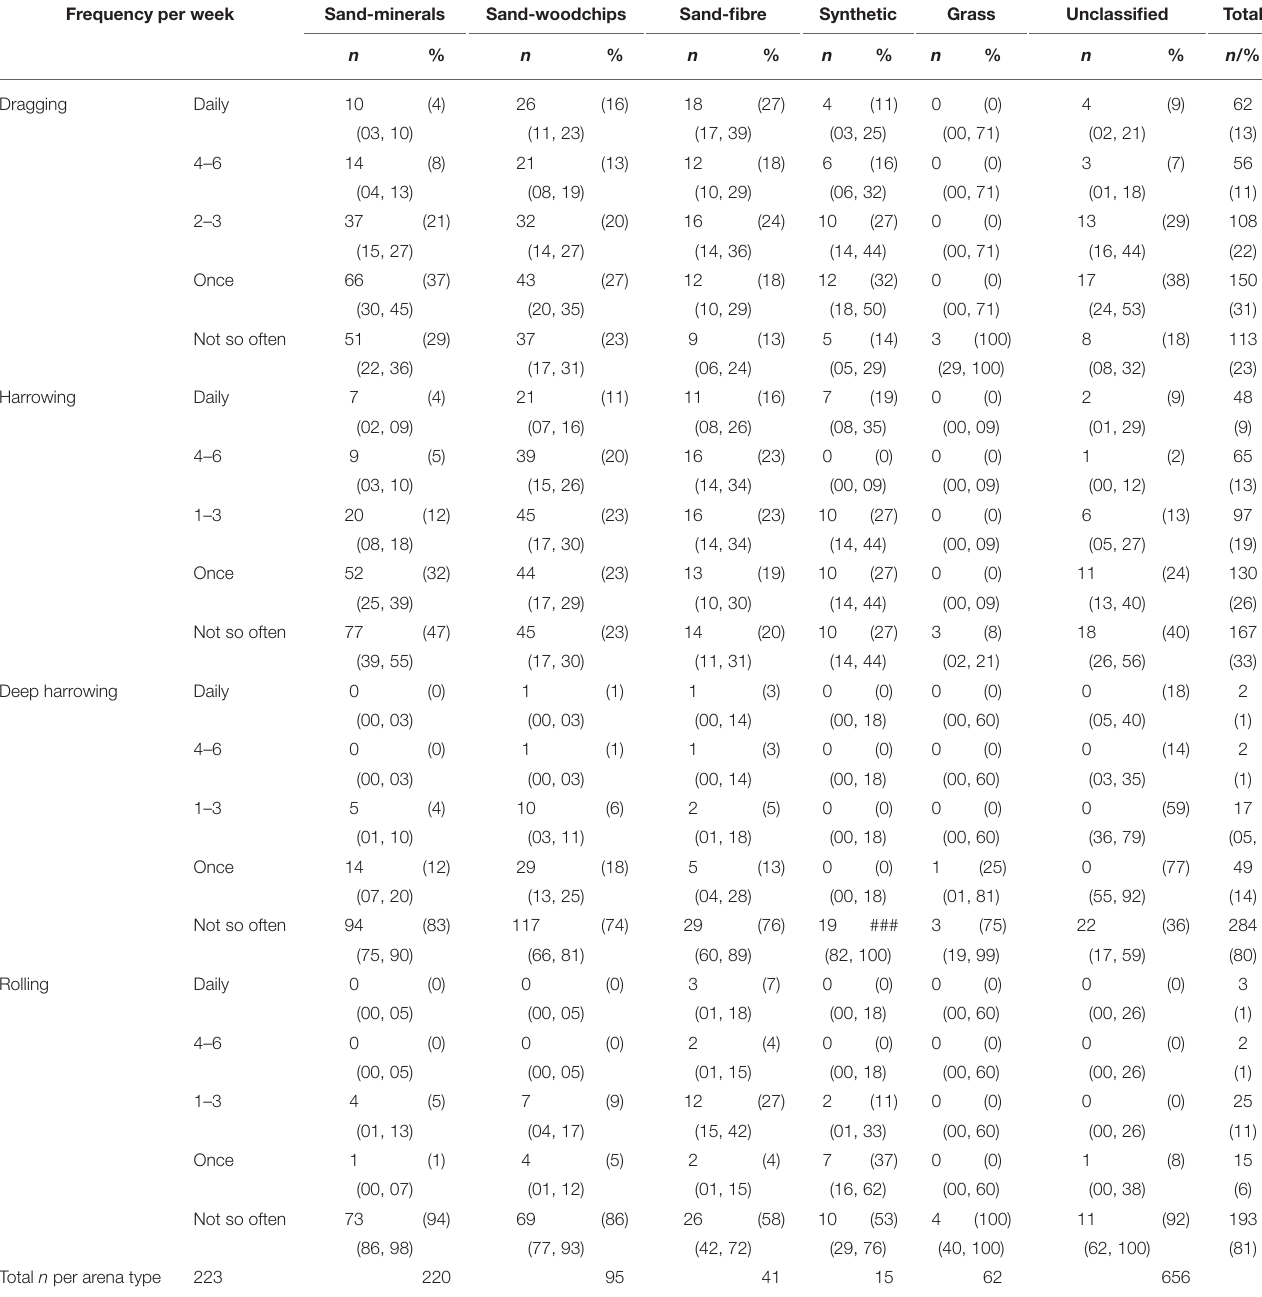
TABLE 4 | Frequency distributions of means used to maintain the